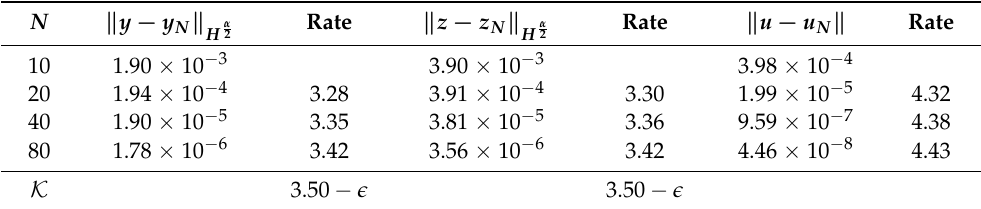
Table 5. Errors and convergence rate of y , z , u in non-weighted Sobolev norm with α = 1.50. N